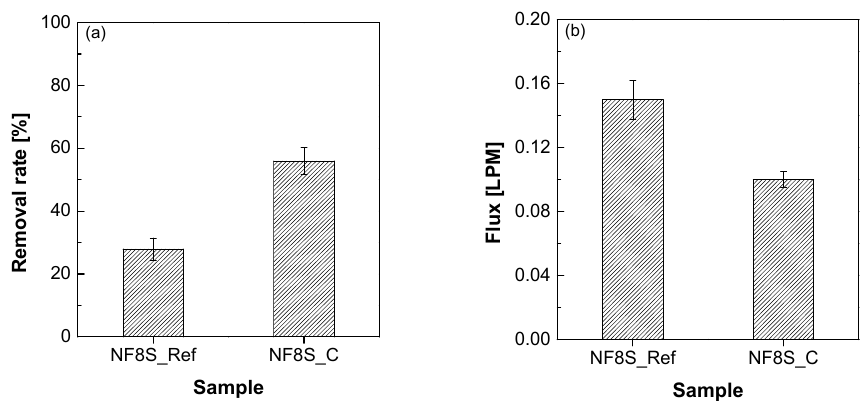
Figure 9. ( a ) Nitrogen nitrate removal rate, and ( b ) filtration